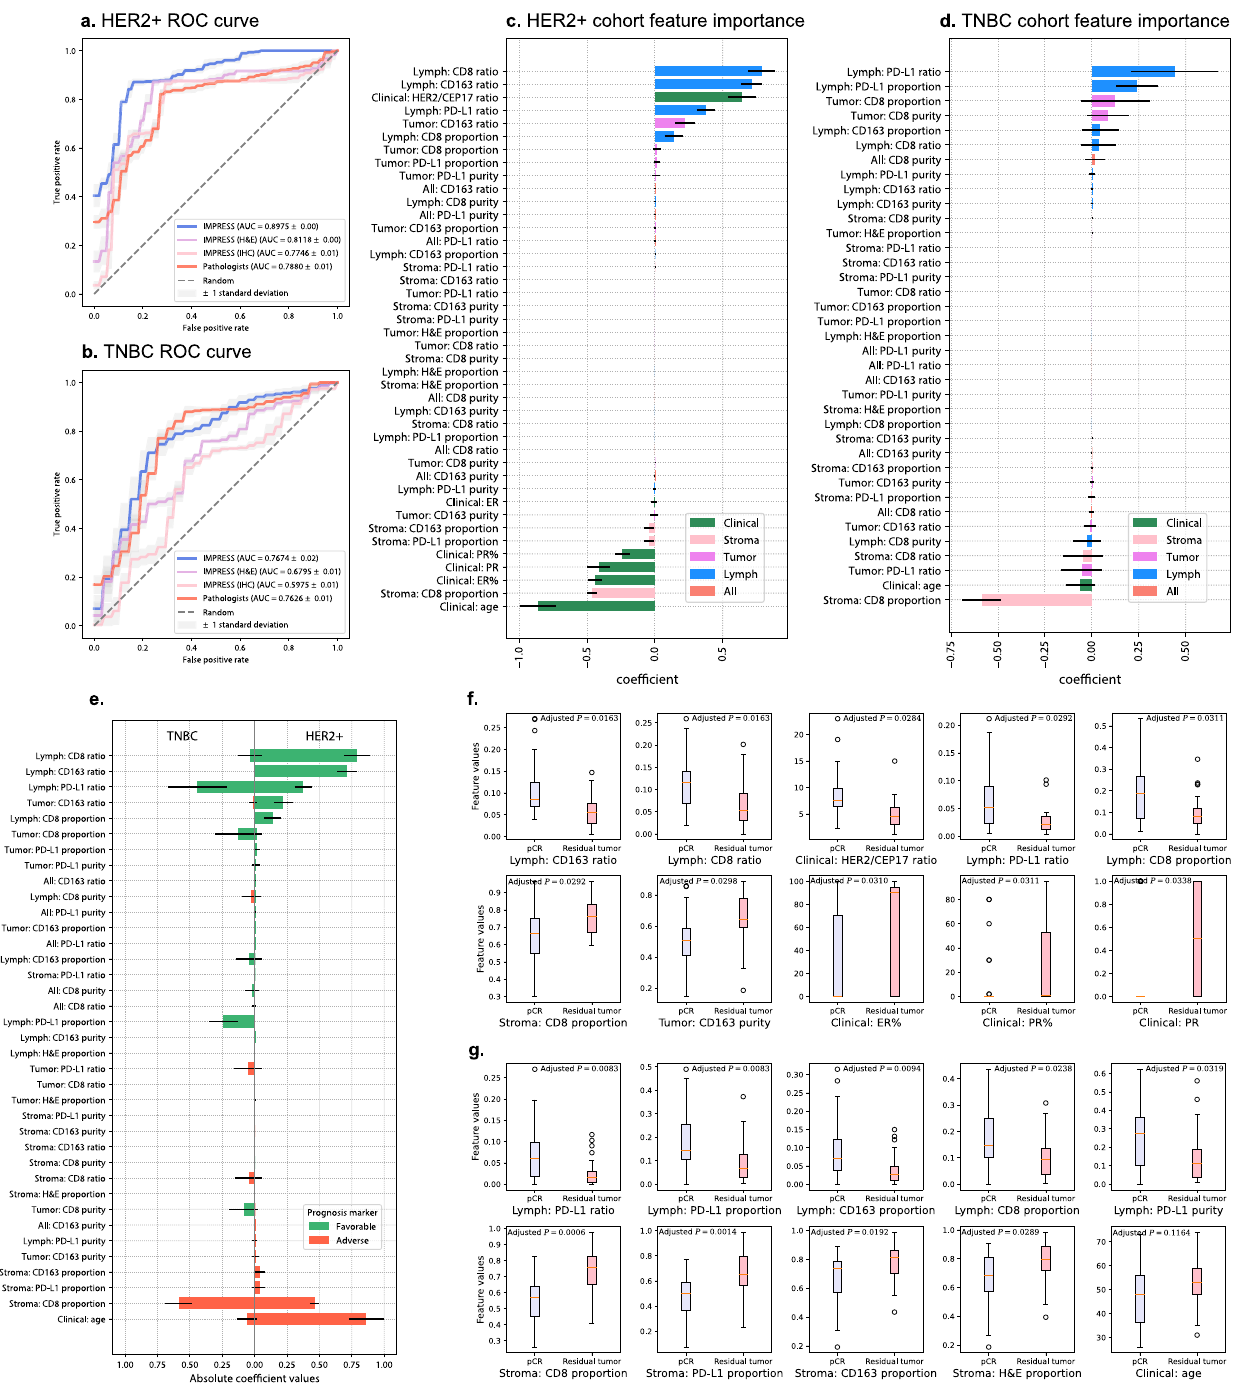
Fig. 3 LASSO-regularized logistic regression machine learning model predicts NAC outcomes. a , b Receiver operating characteristic (ROC) curve for HER2 + ( a ) and TNBC ( b ) cohorts in the logistic regression results. Blue line: IMPRESS plus clinical features; Purple line: IMPRESS (H&E features only) plus clinical features; Pink line: IMPRESS (IHC features only) plus clinical features; Red line: pathologists assessed plus clinical features. c , d Feature importance generated by logistic regression. Positive coef fi cients are associated with better prognosis (pCR) and vice versa. Horizontal line in each bar stands for standard deviation. c HER2 + cohort; d TNBC cohort. e Comparison of IMPRESS and clinical coef fi cient importance in machine learning results between HER2 + and TNBC cohorts, organized by HER2 + coef fi cients in descending order. Coef fi cients in the horizontal bar plot were reported in absolute values, the positive values were de fi ned as “ favorable ” prognostic markers and vise versa for negative values. Figure best viewed in colors. Horizontal line in each bar stands for standard deviation. f , g Univariate feature analysis in HER2 + cohort ( f ) and TNBC cohort ( g ) by comparing pCR cases against residual tumor cases. In f and g , top row showed fi ve most favorable features, bottom row showed fi ve most adverse features. Two-sided P -values were calculated based on Student ’ s t -test, followed with B&H procedure for multiple test adjustment (FDR = 0.05). For boxplot, the interior horizontal red line represents the median value, the upper and lower box edges represent 75 th and 25 th percentile, and the upper and lower bars represent the 90 th and 10 th percentiles,